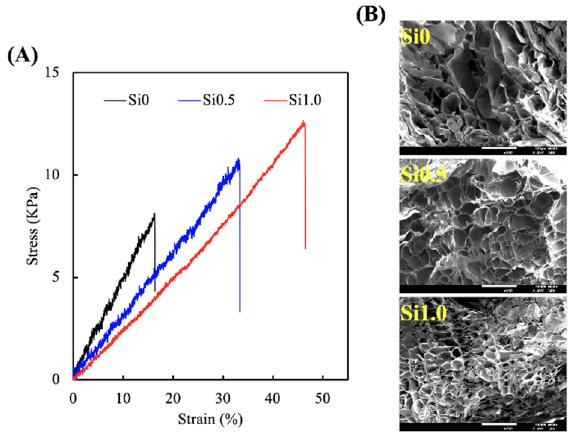
Figure 2. ( A ) Tensile stress–strain curves and ( B ) microstructure of the various Si-GelMa hydrogels.